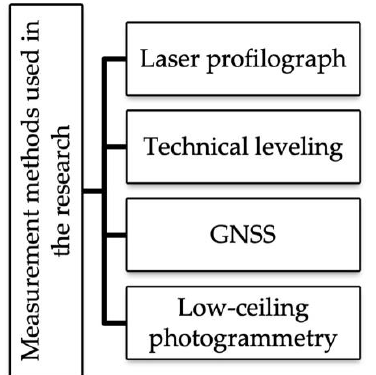
Figure 2. Graph of the measurement methods used in this research.